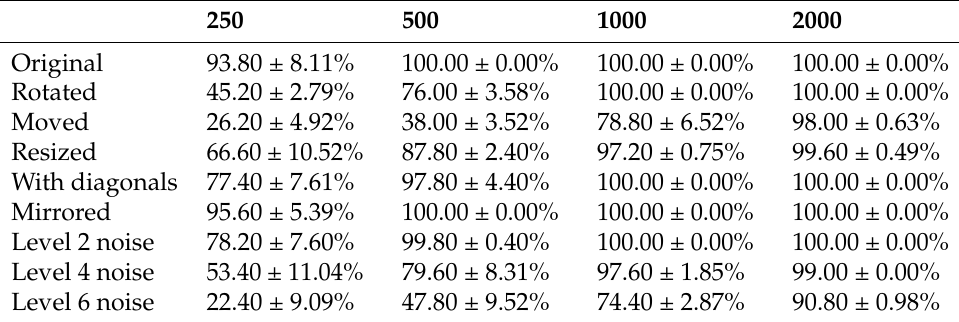
Table 2. Training set: Transformed objects; Test set: Transformed